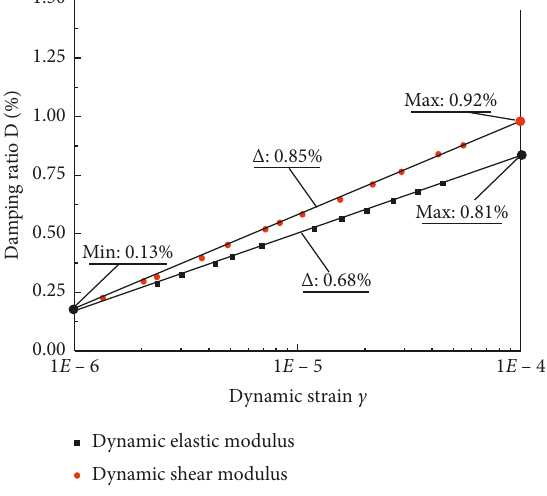
Figure 7: Test results of damping